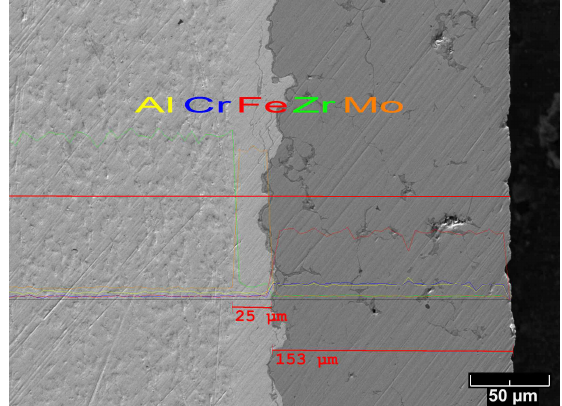
Figure 20. EDS linescan with SEM micrograph of the PT17 sample. The thickness of the Mo interlayer is around 25 µ m and FeCrAl LA coating is about 150 µ m thick. High number of cracks is visible in both Mo and